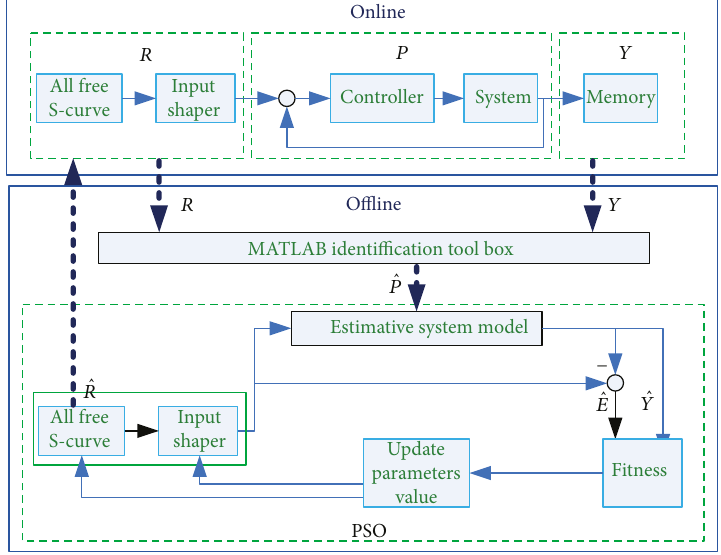
Figure 4: Online-o ffl ine optimize control system block